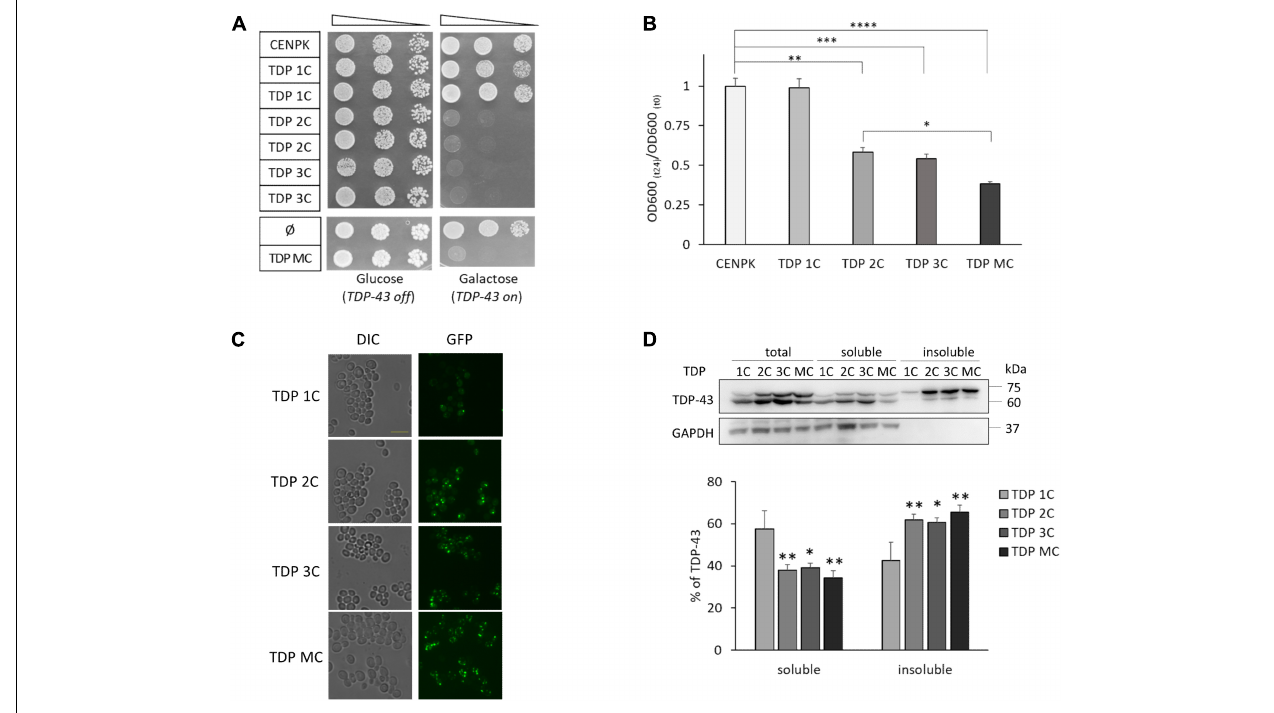
FIGURE 1 | Two or more copies of the human TDP-43 transgene are lethal to S. cerevisiae cells, with increasing levels of TDP-43 in detergent-insoluble fraction. (A) The viability of the unmodified S. cerevisiae strain (CENPK) was compared to yeast strains carrying in the genome one (TDP 1C), two (TDP 2C), or three (TDP 3C) copies of the wild-type (WT) TDP-43 transgene (upper panel) or transformed with either non-integrative multi-copy plasmid empty (ø), or coding for human TDP-43 (TDP MC) (lower panel). Yeast cells (OD 600 = 1) of each strain were serially diluted (10-fold) and spotted onto either inducing medium plates (galactose, TDP-43 on), or repressing condition as control (glucose, TDP-43 off), and incubated at 30 ◦ C for 3 days. Data are representative of three experiments yielding comparable results. (B) After inducing TDP-43 expression in galactose-containing liquid medium (24 h, 30 ◦ C), the growth rate of the above yeast strains was measured as the ratio of the OD 600 at the end ( t 24 ) and the beginning ( t 0 ) of induction [OD 600 ( t 24 )/OD 600 ( t 0 )]. Data [mean ± standard error of the mean (SEM)] are reported after normalization to the mean value of the CENPK strain. n = 12, ∗ p < 0.05, ∗∗ p < 0.01, ∗∗∗ p < 0.001, ∗∗∗∗ p < 0.0001 Kruskal–Wallis test followed by a Dunn’s post hoc test. (C) After TDP-43 induction in galactose-containing liquid medium (6 h, 30 ◦ C), cells of the different yeast strains were observed by epifluorescence microscopy (GFP) to visualize the expression of the TDP-43-GFP fusion protein. For each fluorescence image, differential interference contrast (DIC) micrograph is also reported. Images are representative of three biological replicates for each strain. Scale bar , 10 µ m. (D) RIPA-lysates from yeast strains, harboring the indicated copies of the TDP-43 transgene, were subjected to biochemical separation of detergent-soluble and -insoluble protein fractions. Total, soluble and insoluble fractions (1:1:1 ratio) were analyzed by WB for the presence of TDP-43 or GAPDH as a control for RIPA-soluble proteins (upper panel). The lower panel reports the densitometric analysis of TDP-43-immunoreactive bands in RIPA-soluble and -insoluble fractions quantified as described in Materials and Methods. Here and after, data are reported as mean ± SEM, n = 3 (here and after indicating biological replicates), ∗ p < 0.05, ∗∗ p < 0.01, one way ANOVA with Sidak correction for comparison of TDP 2C, TDP 3C and TDP MC to TDP